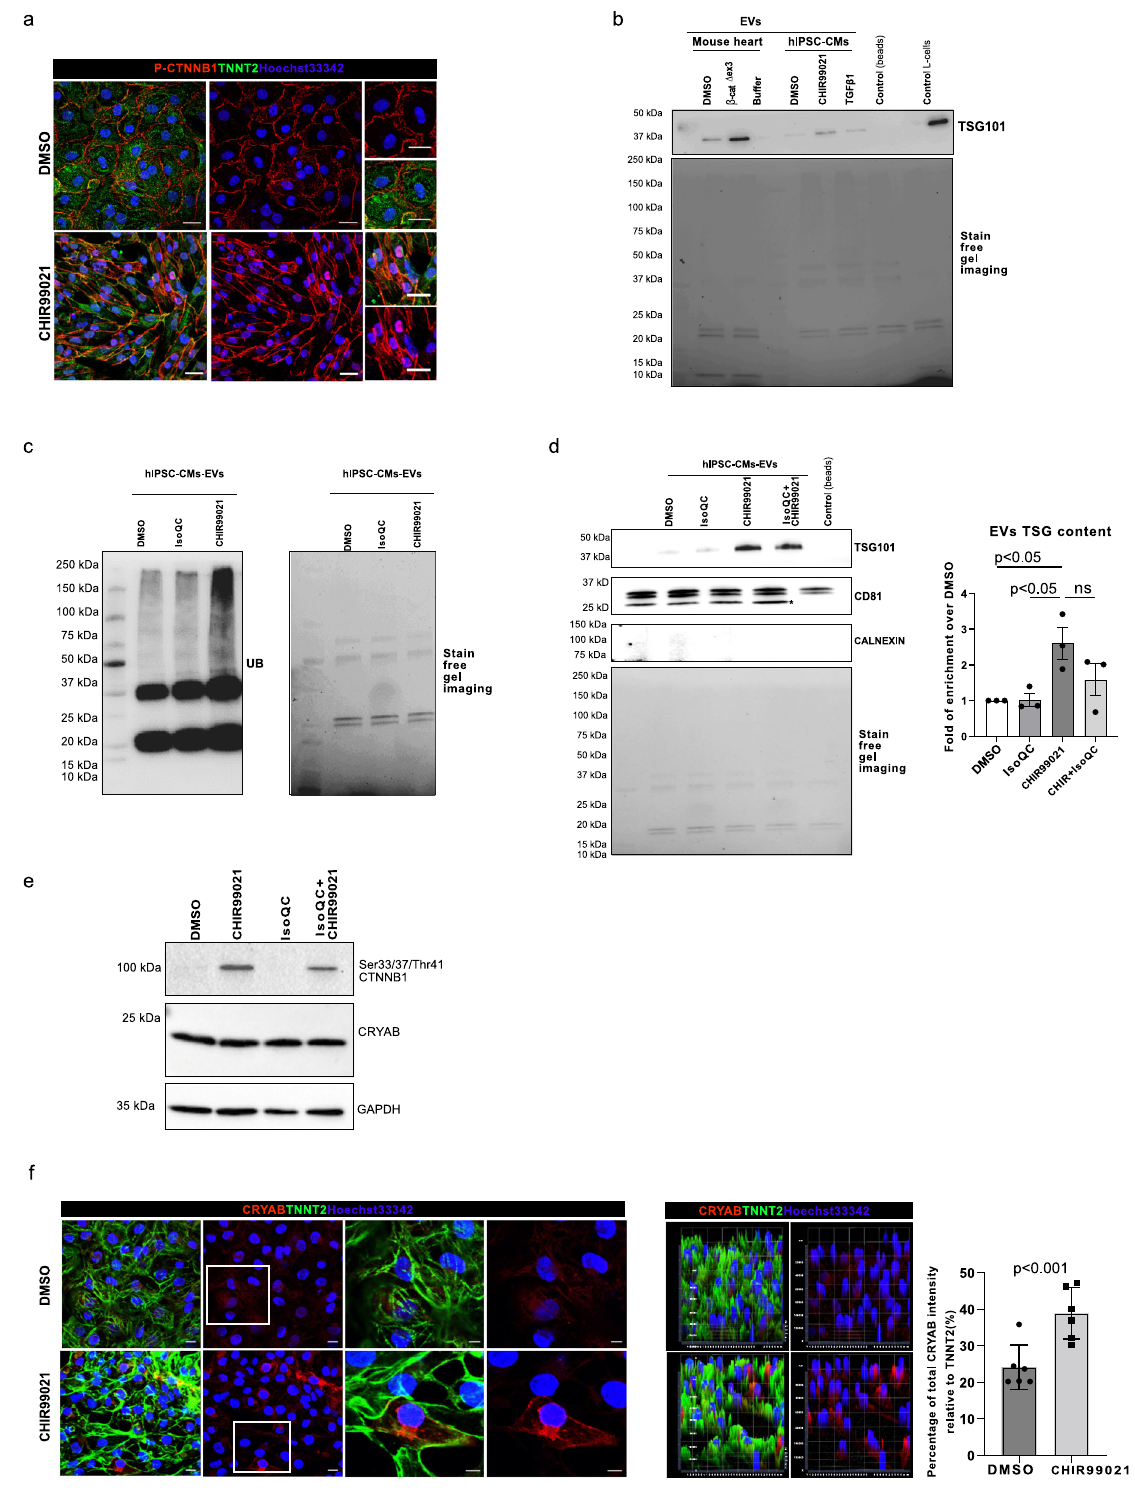
signi fi cantly upregulated genes categorizing to vesicle-mediated transport, late endosome, phagosome and MVB processes as